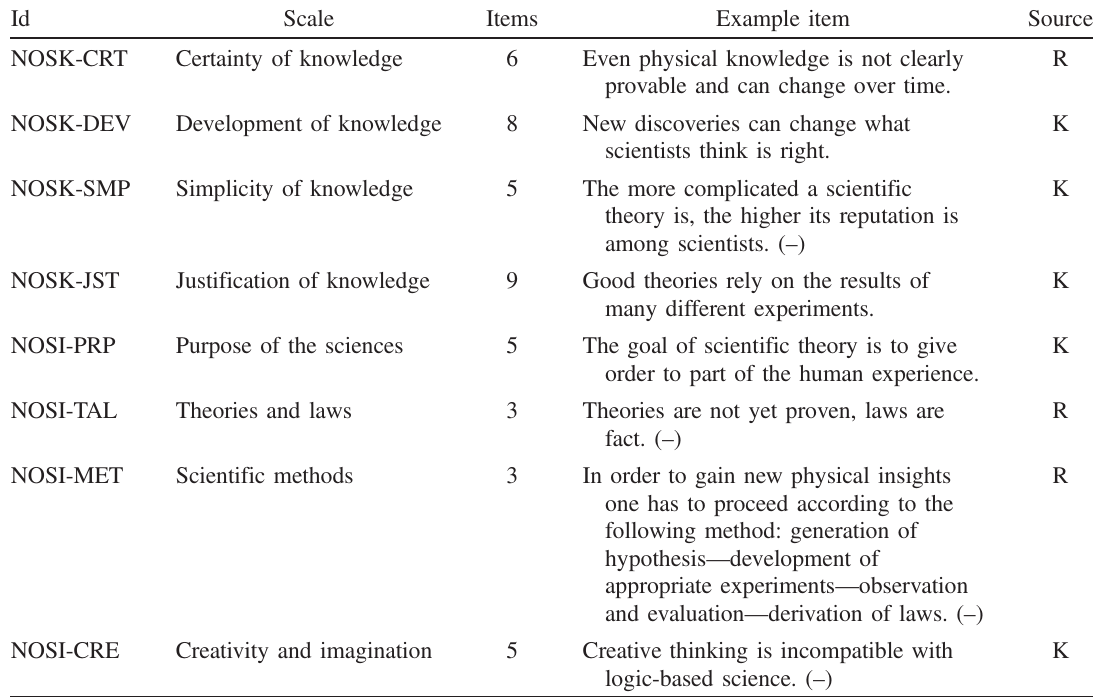
TABLE II. Overview of the test instrument. Example items marked ( – ) are inverted. Scales from Kremer ’ s tests [40] are marked K and from Riese [38] R . All test items can be found in the Appendix.